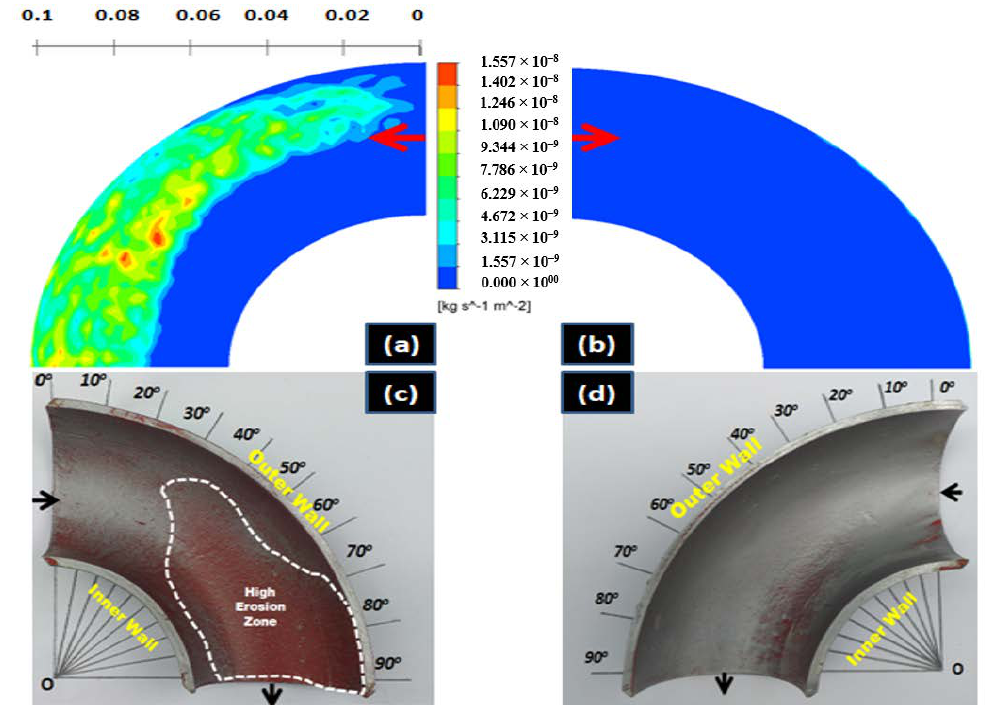
Figure 11. Comparison of erosion pattern for 90° elbow, between prediction and MPM experiments at 0.5 m/s. ( a ) bottom section (CFD) ( b ) upper section (CFD) ( c ) bottom section (MPM) ( d ) upper section (MPM).